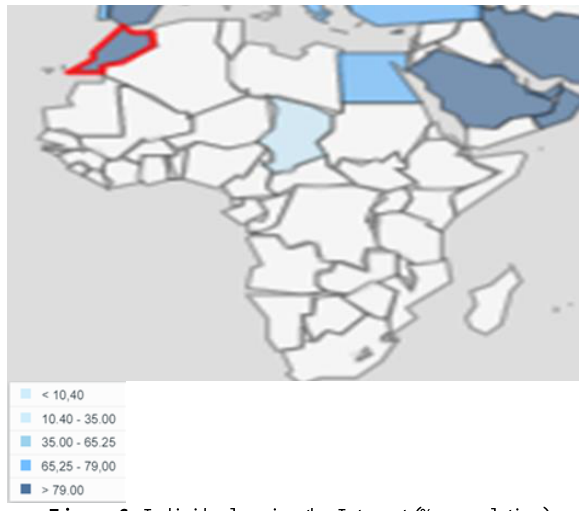
Figure 6: Individuals using the Internet (%